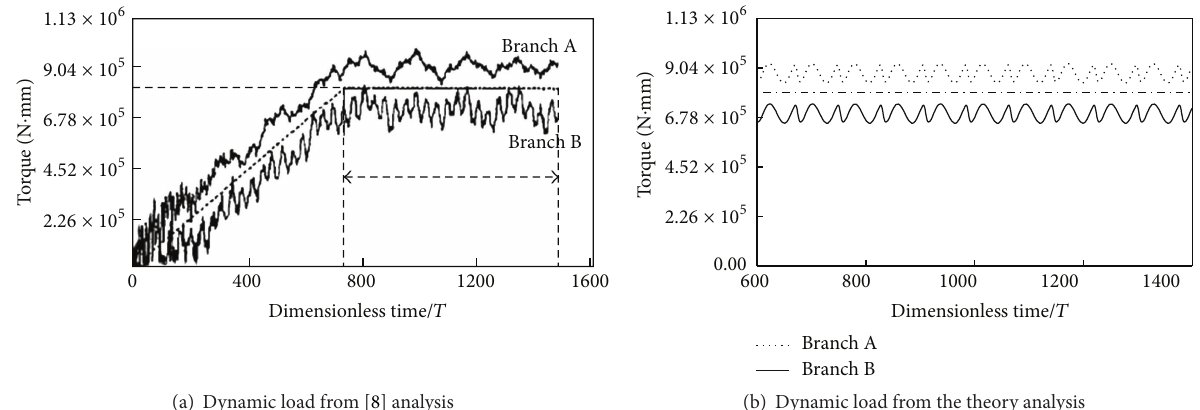
Figure 20: Contrast between theory analysis and [8] calculation of dynamic load with installation